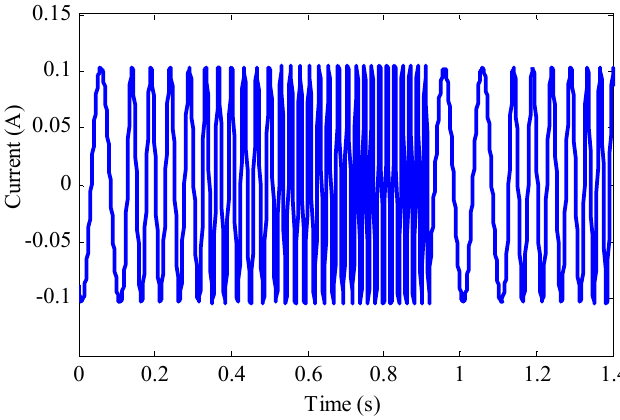
Figure 12. Step response curve of the amplifier.